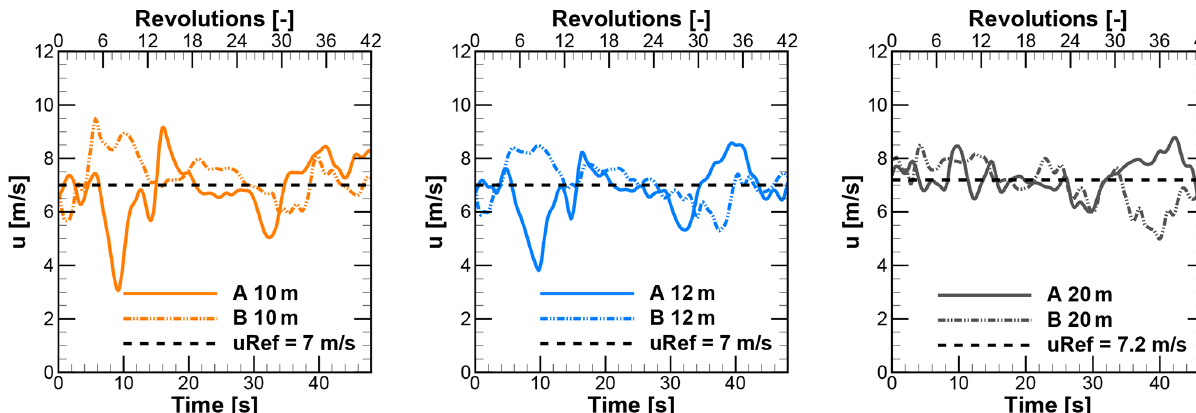
Figure 12. Time series of u component of velocities at different rooftop heights above building A and B.